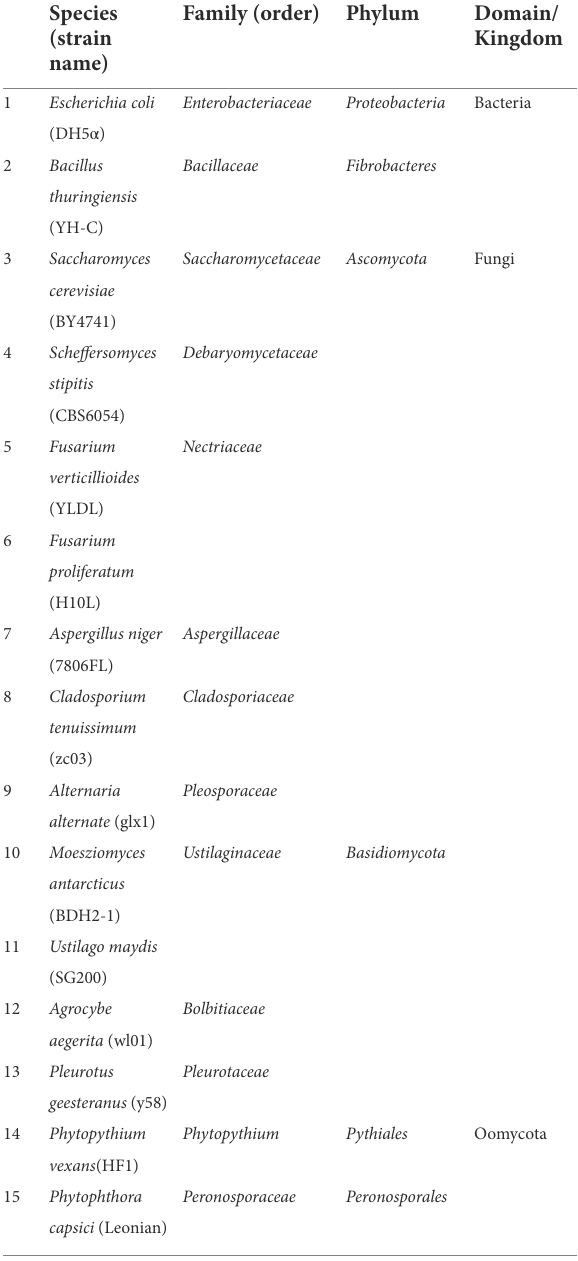
TABLE 1 Microbial species and strains (in parenthesis) analyzed in this